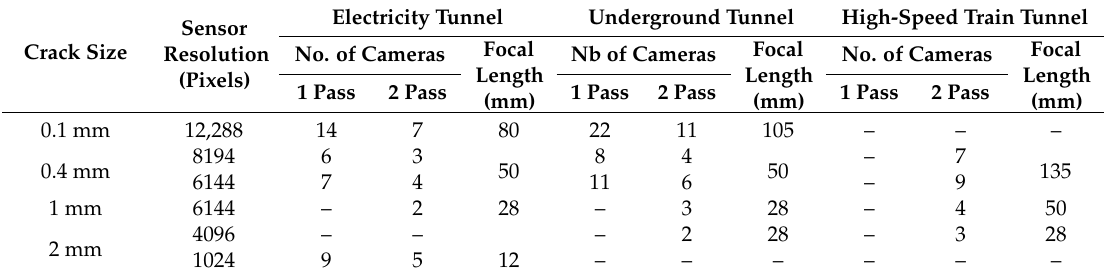
Table 3. Number of cameras and their recommended sensor resolution for the different tunnel